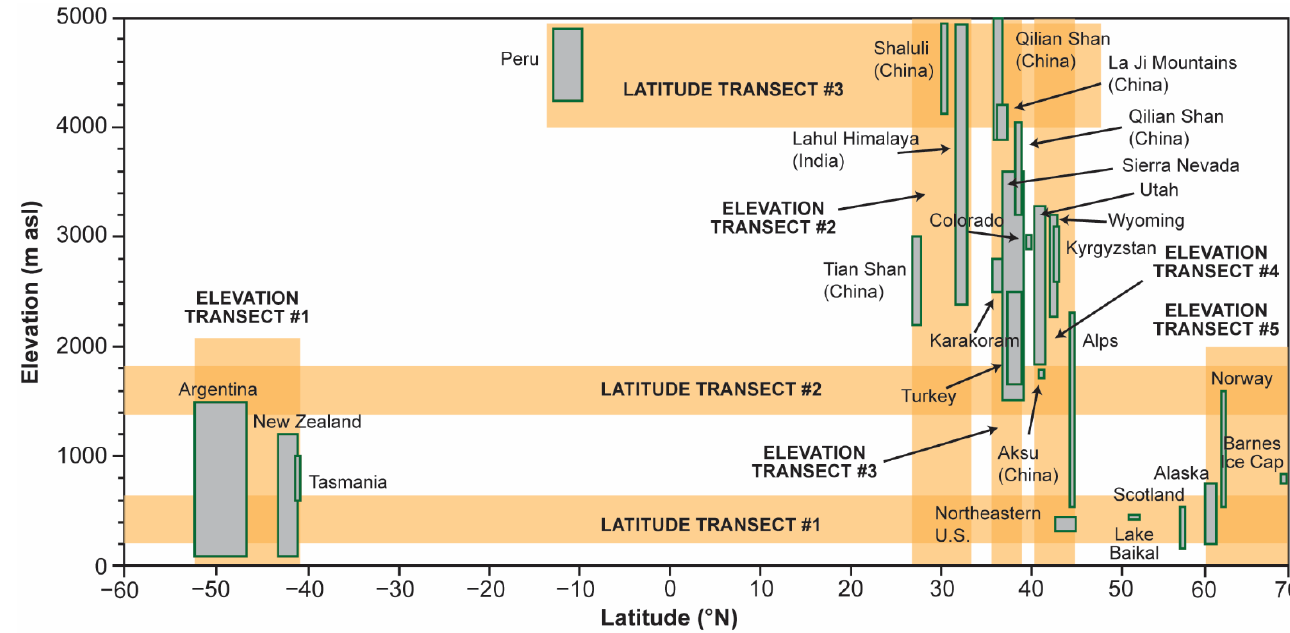
Figure 1. Sample locations and study design.